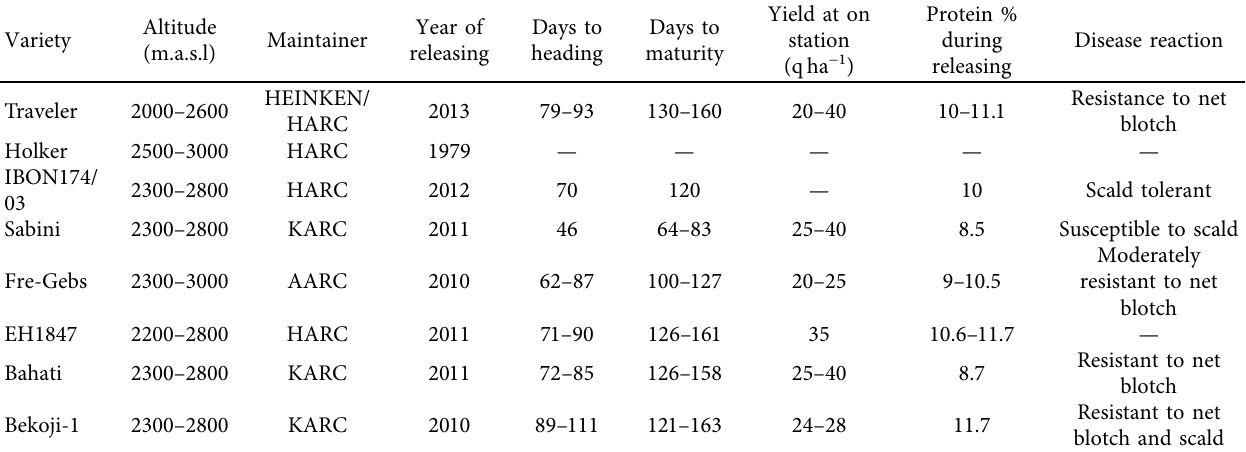
Table 2: Description the eight malting barley varieties used for the